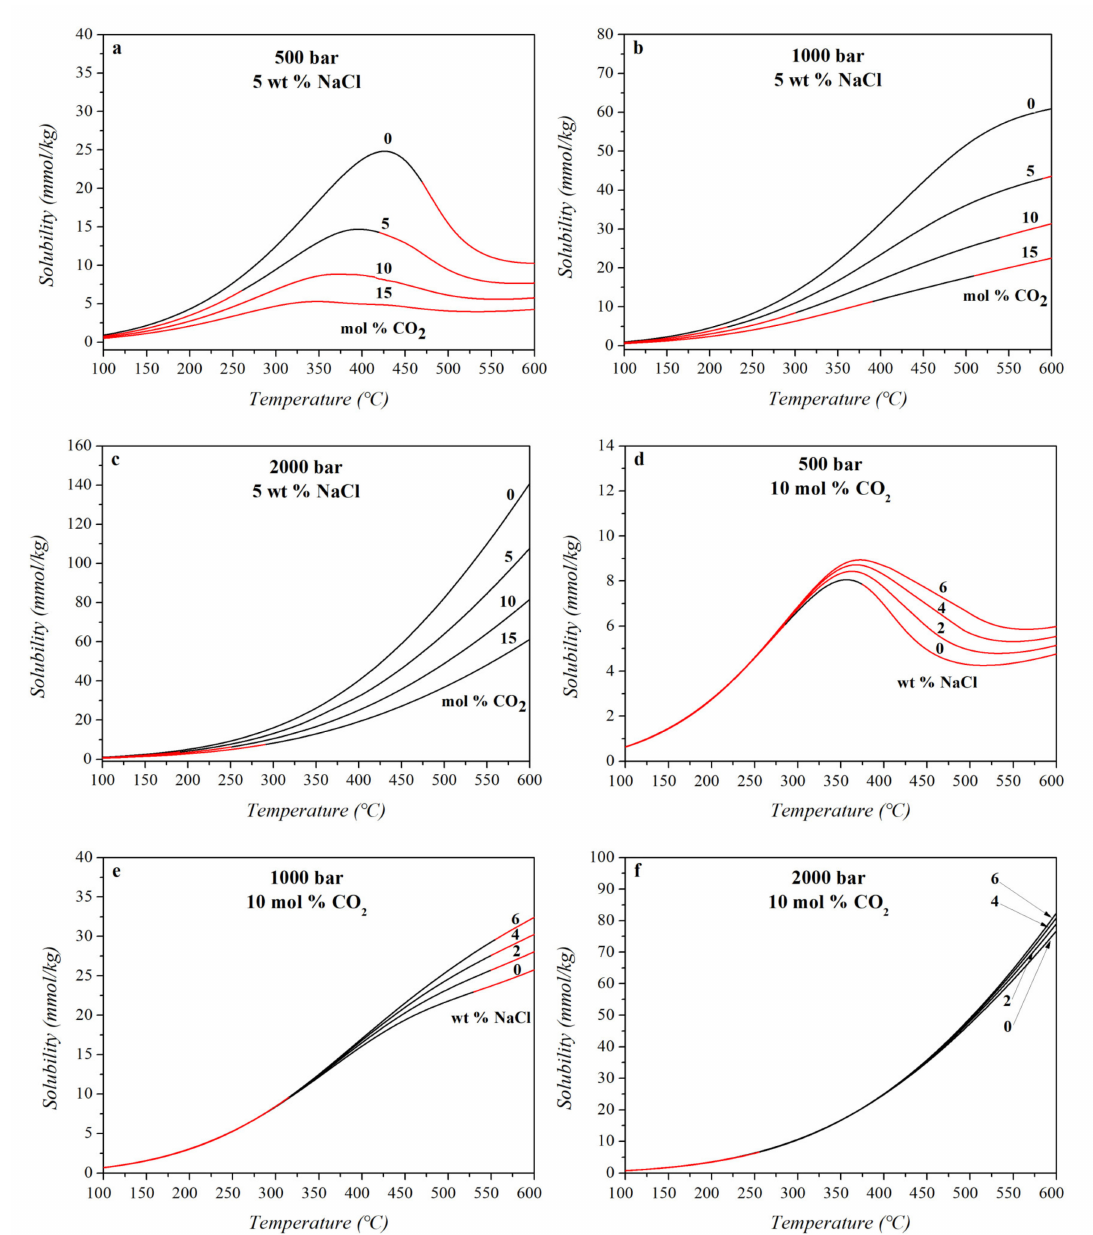
Figure 10. Predictions of quartz solubility in H 2 O-CO 2 -NaCl hydrothermal solutions. ( a – c ) are the fluids containing of 5 wt% NaCl and 0 mol%–15 mol% CO 2 compositions at 500, 1000, and 2000 bar conditions respectively; ( d – f ) are the fluids containing of 10 mol% CO 2 and 0 wt%–6 wt% NaCl compositions at 500, 1000 and 2000 bar conditions respectively; Notes: The computing results were obtained from AD model (2009). Black lines represent quartz solubility in liquid phase of hydrothermal fluids, and the red lines are quartz solubility in vapor + liquid phase of hydrothermal fluids. Quartz solubility in millimole SiO 2 per kilogram